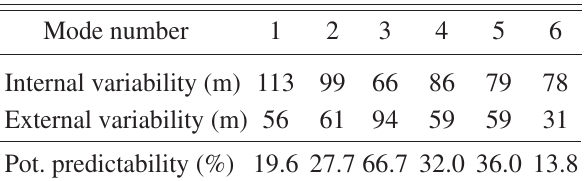
Table V. Same as in table III, but for the experiment GLOBAL. The 99% significance level is reached when potential predictability is